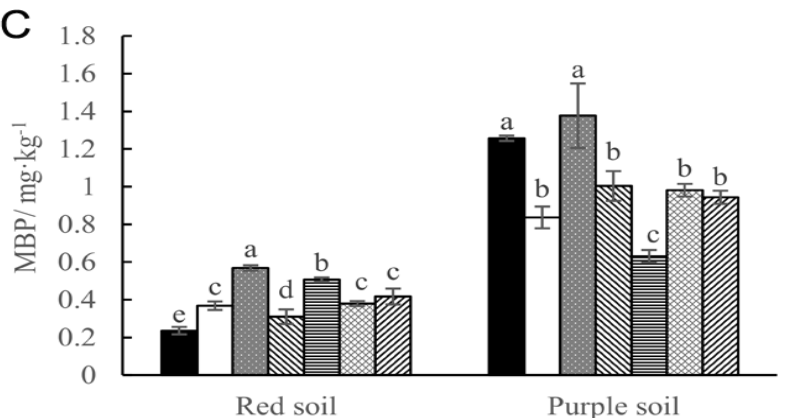
Figure 3. Soil microbial biomass in both soils after 180 days of incubation. The X -axis indicates di ff erent soil types, including red soil and purple soil. ( A ): MBC in both soils after 180 days of incubation. ( B ): MBN in both soils after 180 days of incubation. ( C ): MBP in both soils after 180 days of incubation. Control: red / purple soil without biochar application; Abbreviation: MBC represents microbial biomass carbon; MBN indicates microbial biomass nitrogen; MBP indicates microbial biomass phosphorus; Error bars indicating S.E, ( n = 3). Di ff erent lowercase letters within a line indicated significant di ff erences among treatments at the p < 0.05 level.